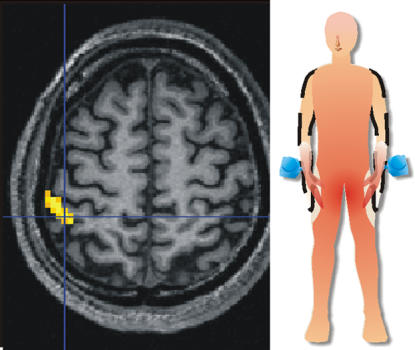
Higher-order somatosensory areas in the parietal cortex mediate perceived changes in body shape and size